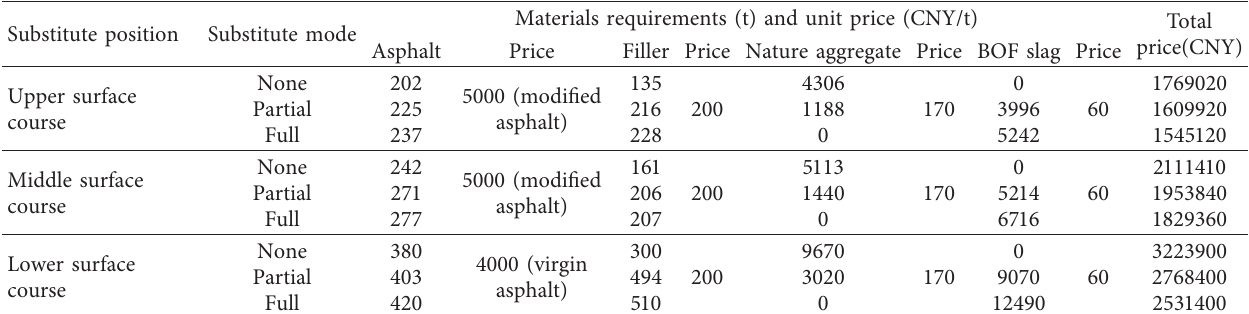
Table 6: Price list of asphalt mixture with BOF slag.